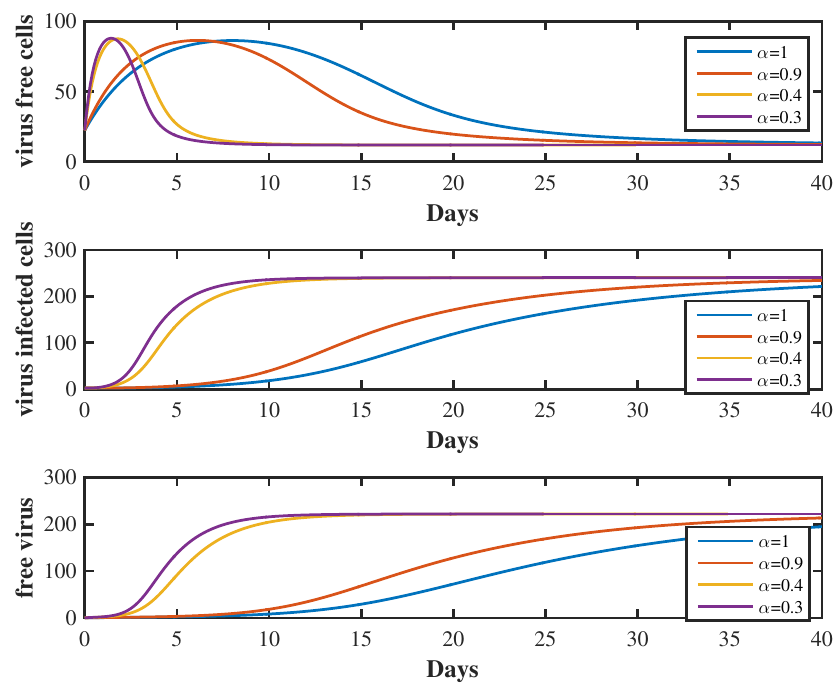
Figure 3. Numerical solution of the model (2) under different α values. In Figure 4, we use the same initial condition and data but fix α = 0.9 with different values of β . We find that the number of virus-free cells decreases and all numbers of virus- infected cells and virus-free cells increases, while the solution of the model (2) approaches e 2 , which means that the e 1 becomes